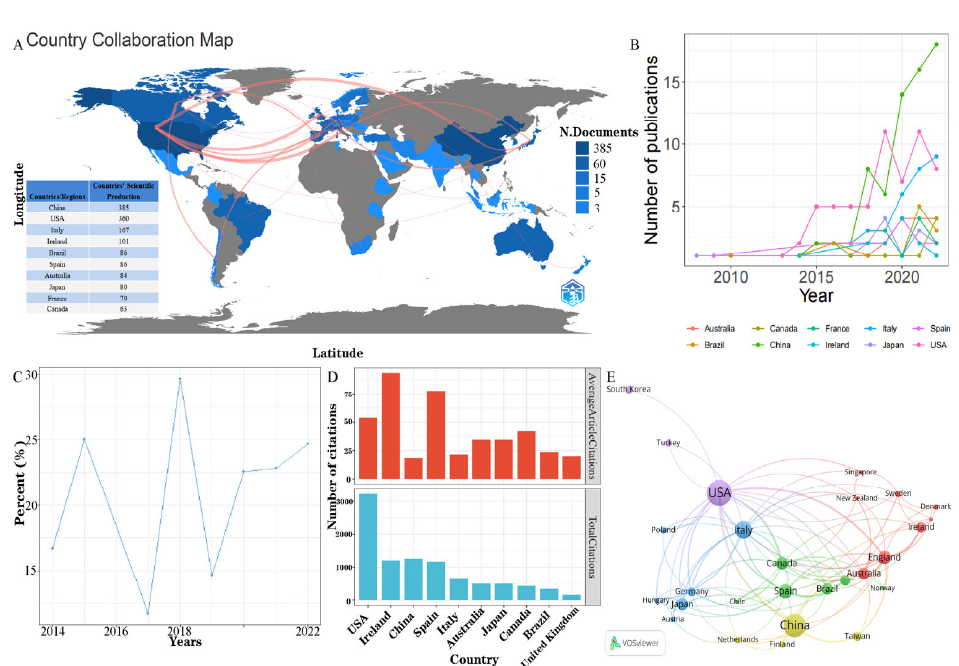
Figure 3. ( A ) Global distribution and international interactions of research in the field of the microbiome and exercise. ( B ) The annual distribution of research in the field of the microbiome and exercise, from the top 10 countries between 2008 and 2022. ( C ) The annual proportion of research in the field of the microbiome and exercise from China. ( D ) Total and average number of article citations in the top ten most highly cited countries. ( E ) Network visualization map of international research collaboration in the microbiome and exercise among the leading active countries.